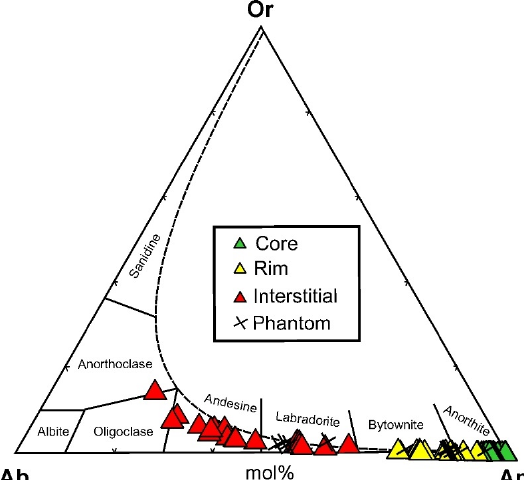
Figure 6. Ternary Ab ‐ An ‐ Or classification diagram of plagioclases with miscibility gap (dashed curve) calculated for 900 °C and 1 GPa using the ternary feldspar mixing model [31].